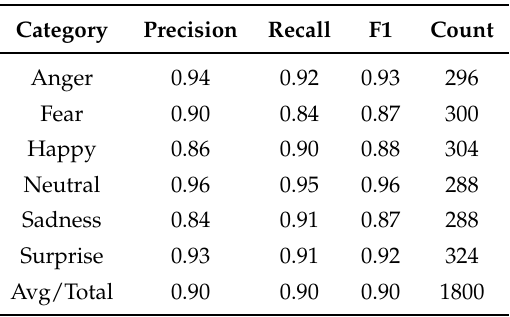
Table 4. Recognition results using proposed method on